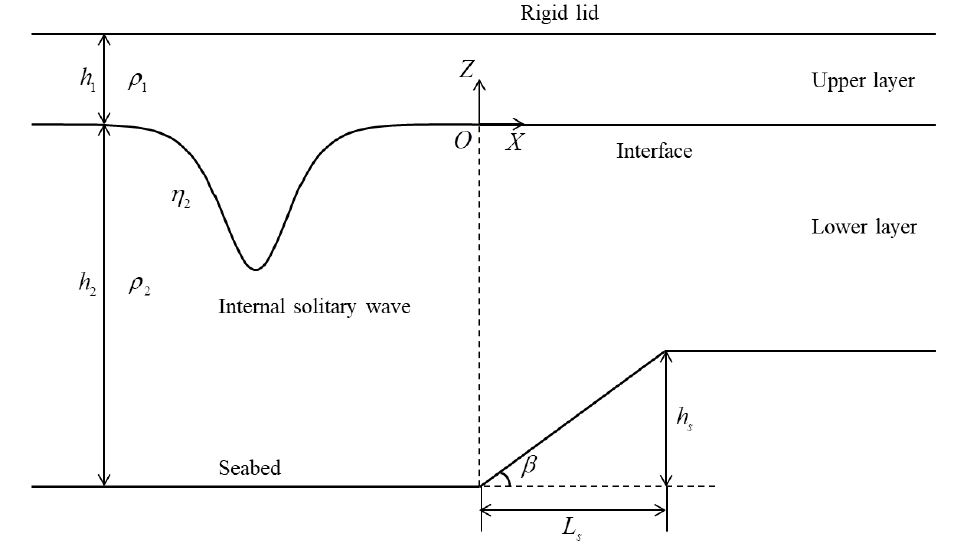
Figure 1. Schematic of the numerical simulation domain, where the fluid of density ρ 1 and depth h 1 overlies the fluid of density ρ 2 and depth h 2 . Height of the slope is h s , and horizontal length of the slope is L s .